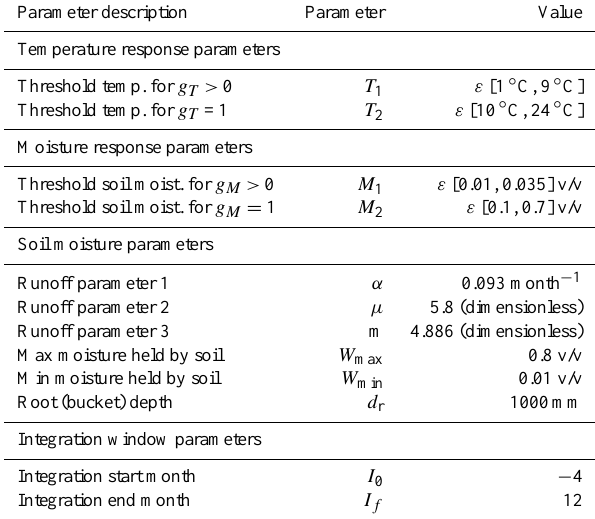
Table 1. VSL model